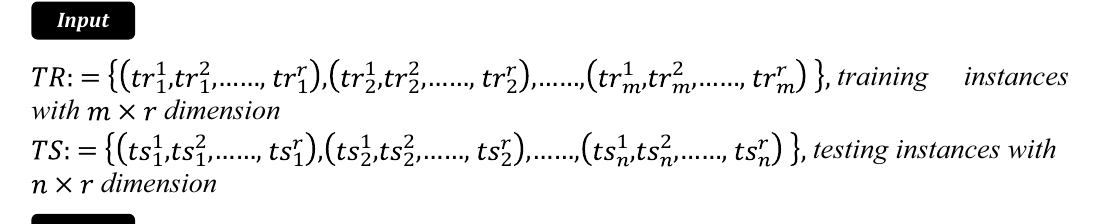
Table 4 Pseudocode of Adaboost